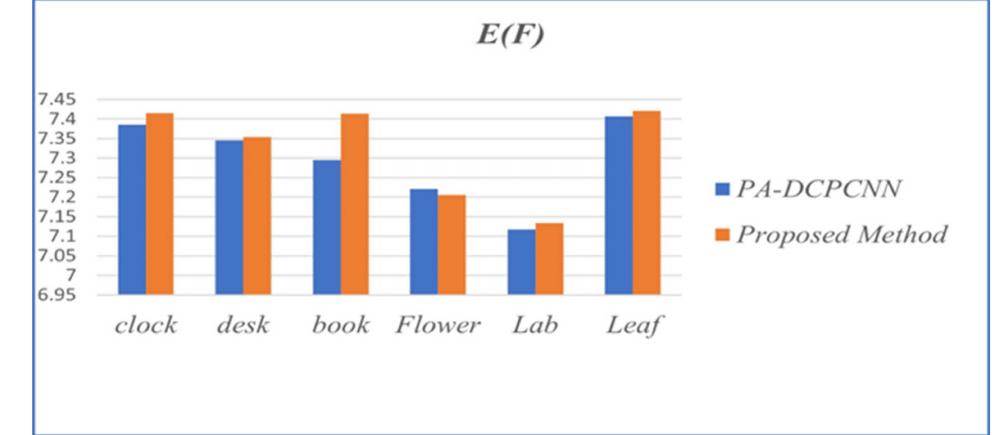
Figure 23. Performance evaluation of image-fusion techniques in reference to E ( F ).